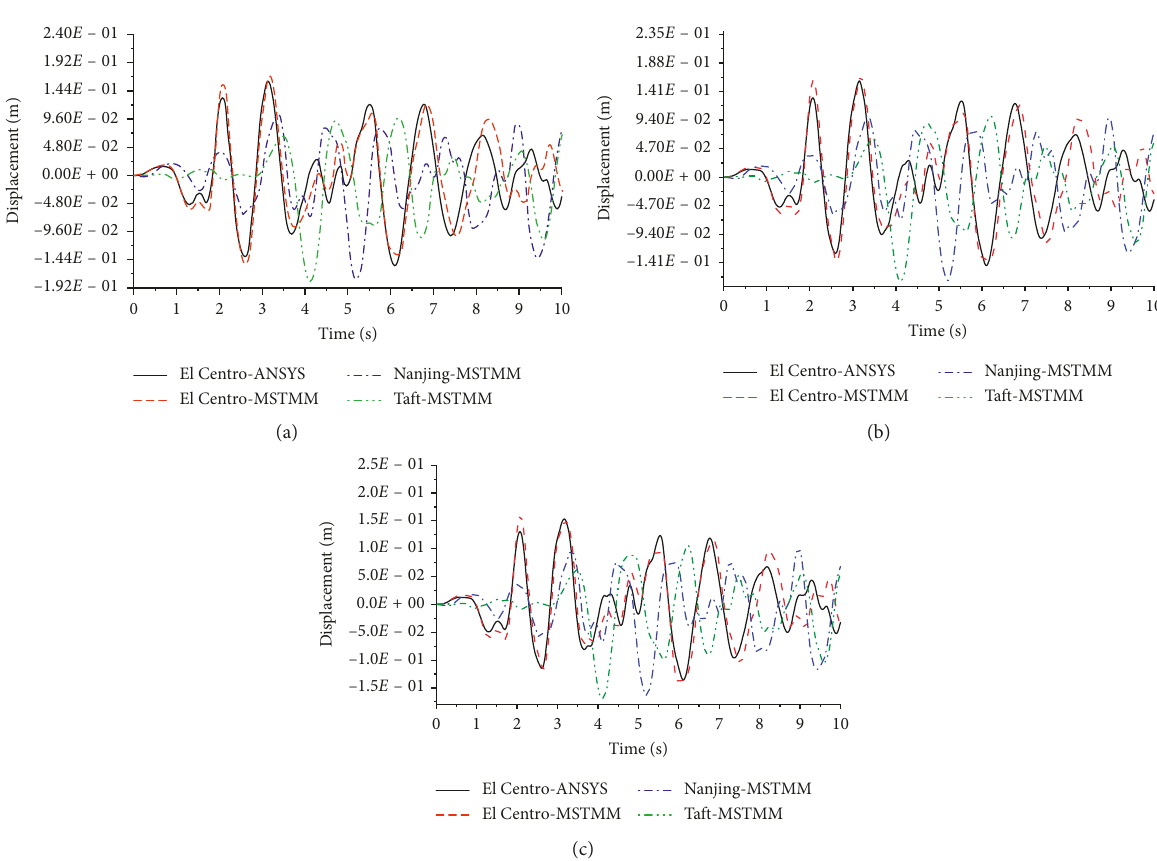
a 2 , 310 displacement under seismic wave (peak acceleration is 220 cm/s